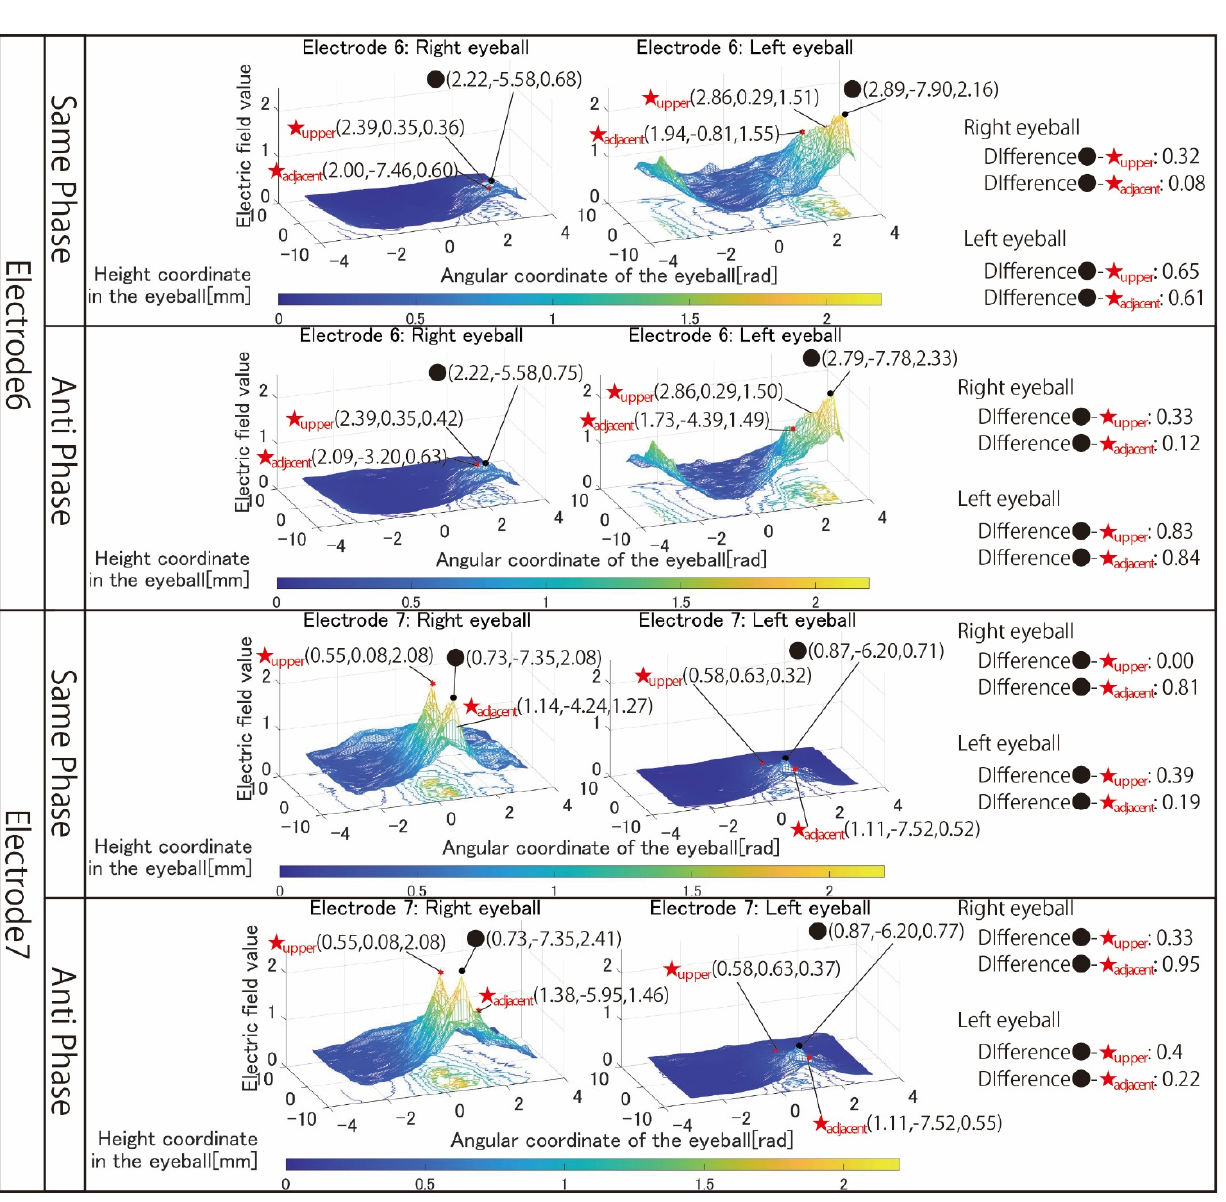
Figure 8. Simulation results with the electrode arrangement to stimulate the temporal and nasal eyeballs.